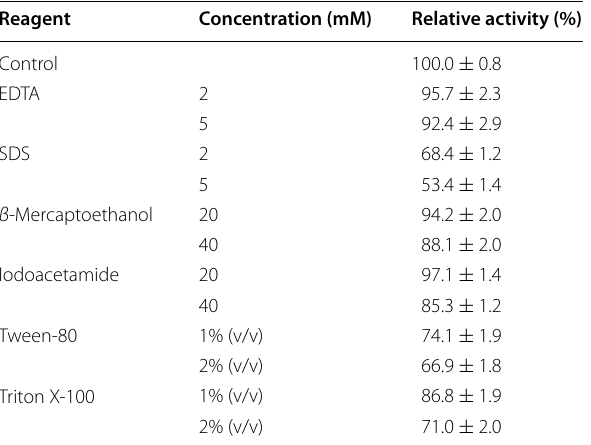
Table 2 Effects of chemical agents on the recombinant